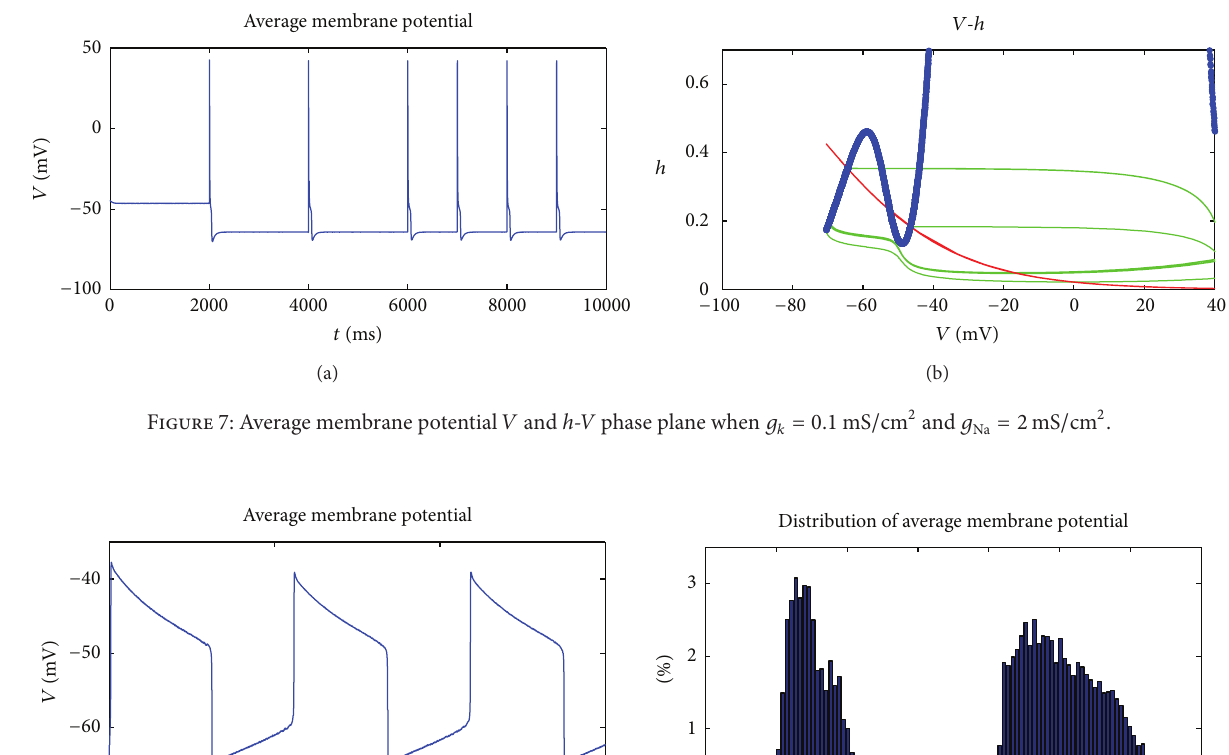
Figure 8: The average membrane potential of spontaneous transitions and its